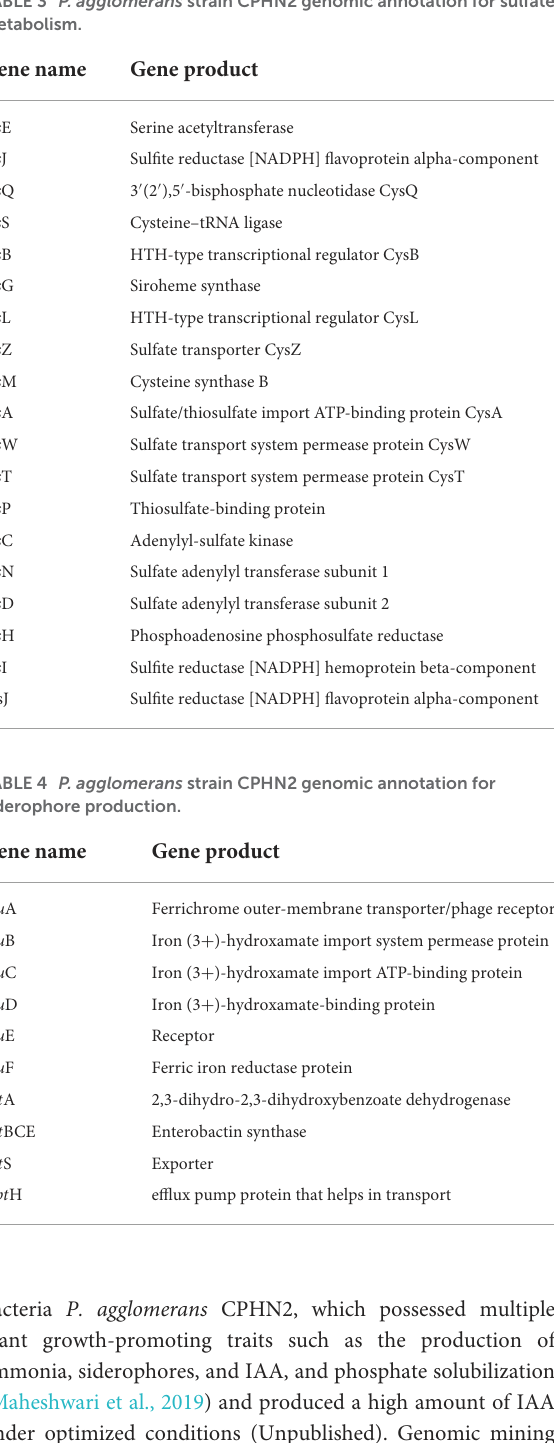
TABLE 2 P. agglomerans strain CPHN2 genomic annotation for phosphate solubilization.